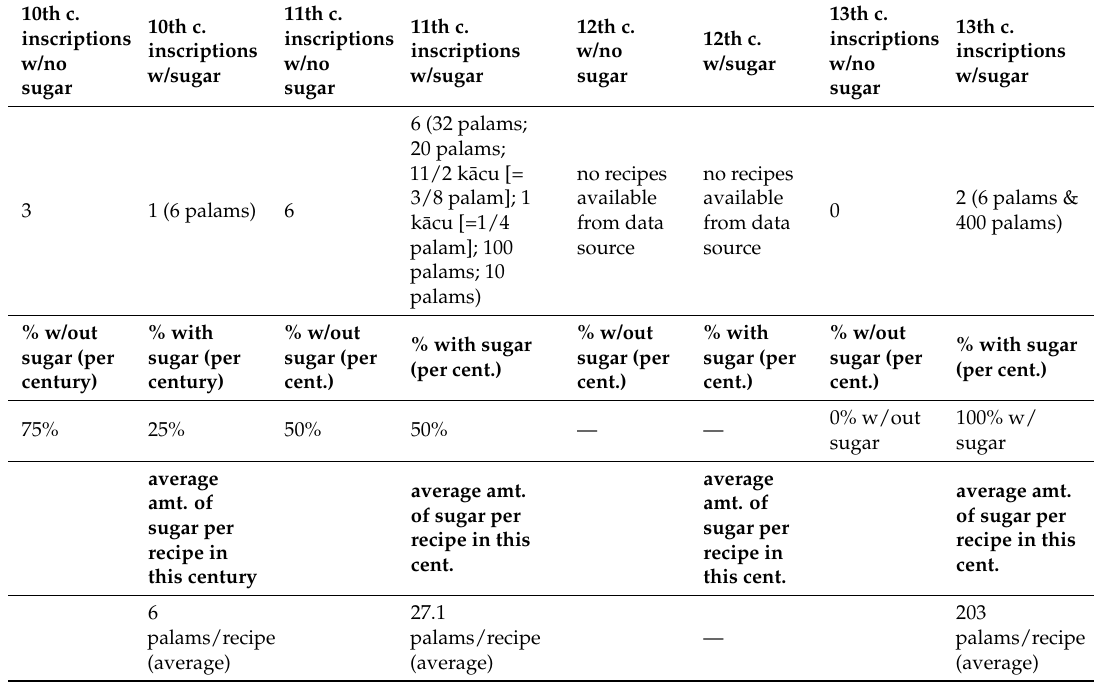
Table 2. C¯ol ¯a period data.